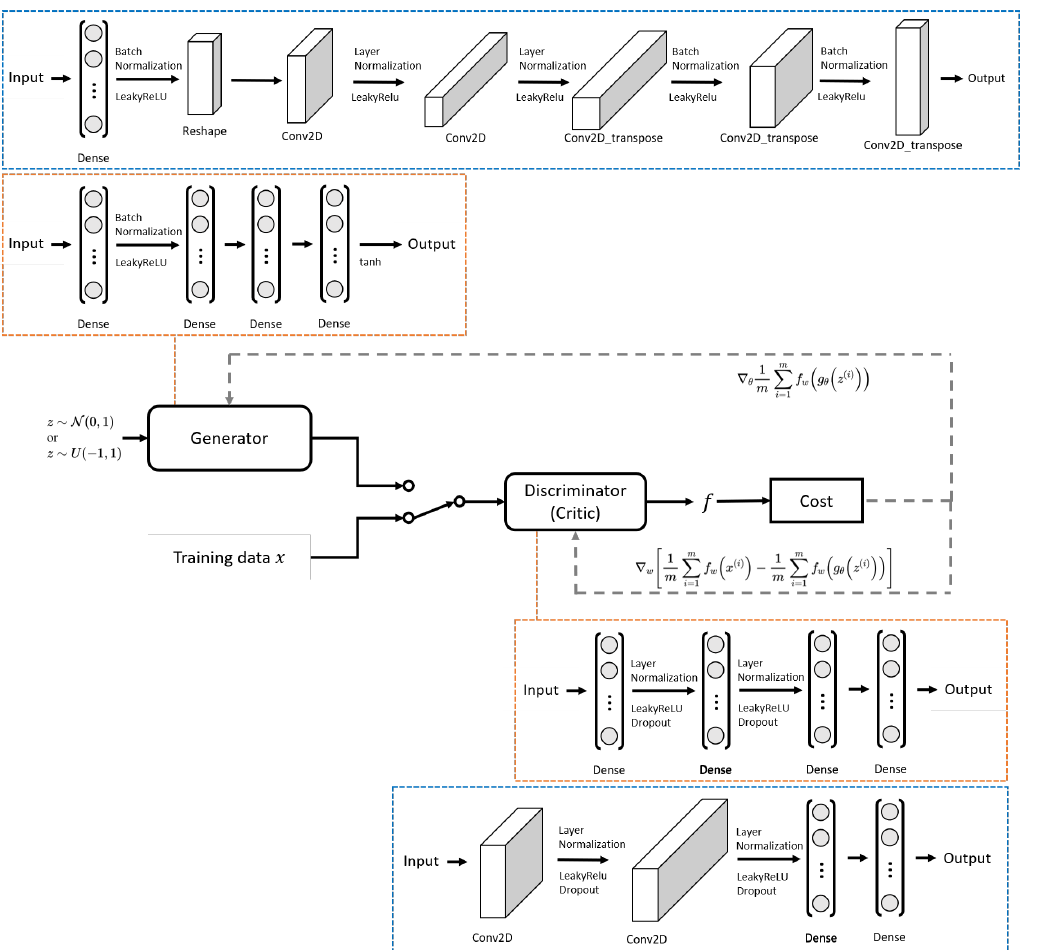
Figure 1. WGAN Structure. The architectures of the Generator and Critic are shown above and below the WGAN structure respectively. The equations displayed are the losses used to update each component. The orange-boxed structure used for the single-output regression problems is a multilayer perceptron network. The blue-boxed structure used for multi-output regression has convolutional